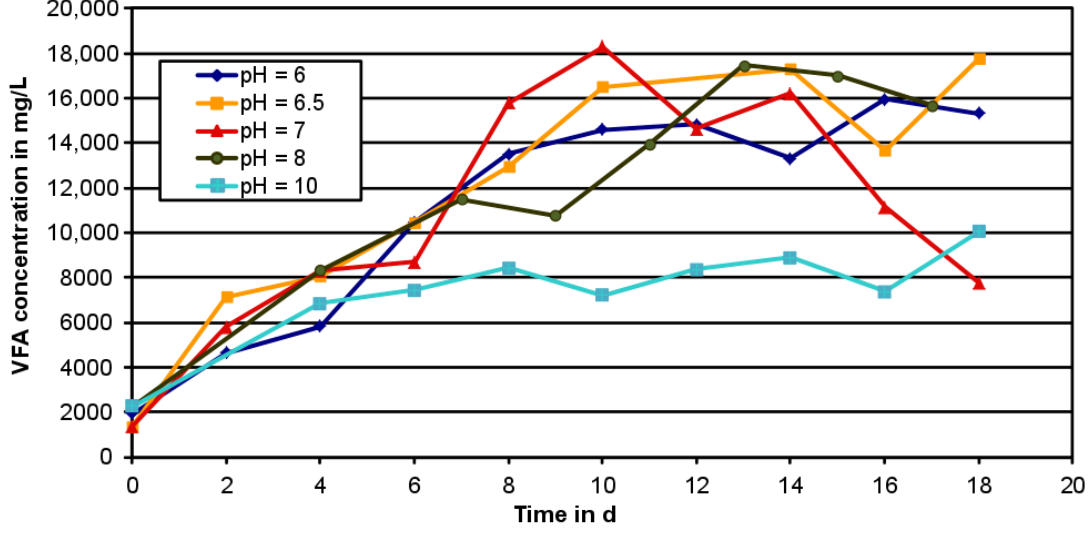
Figure 4. VFA concentrations during tests at different pH levels.